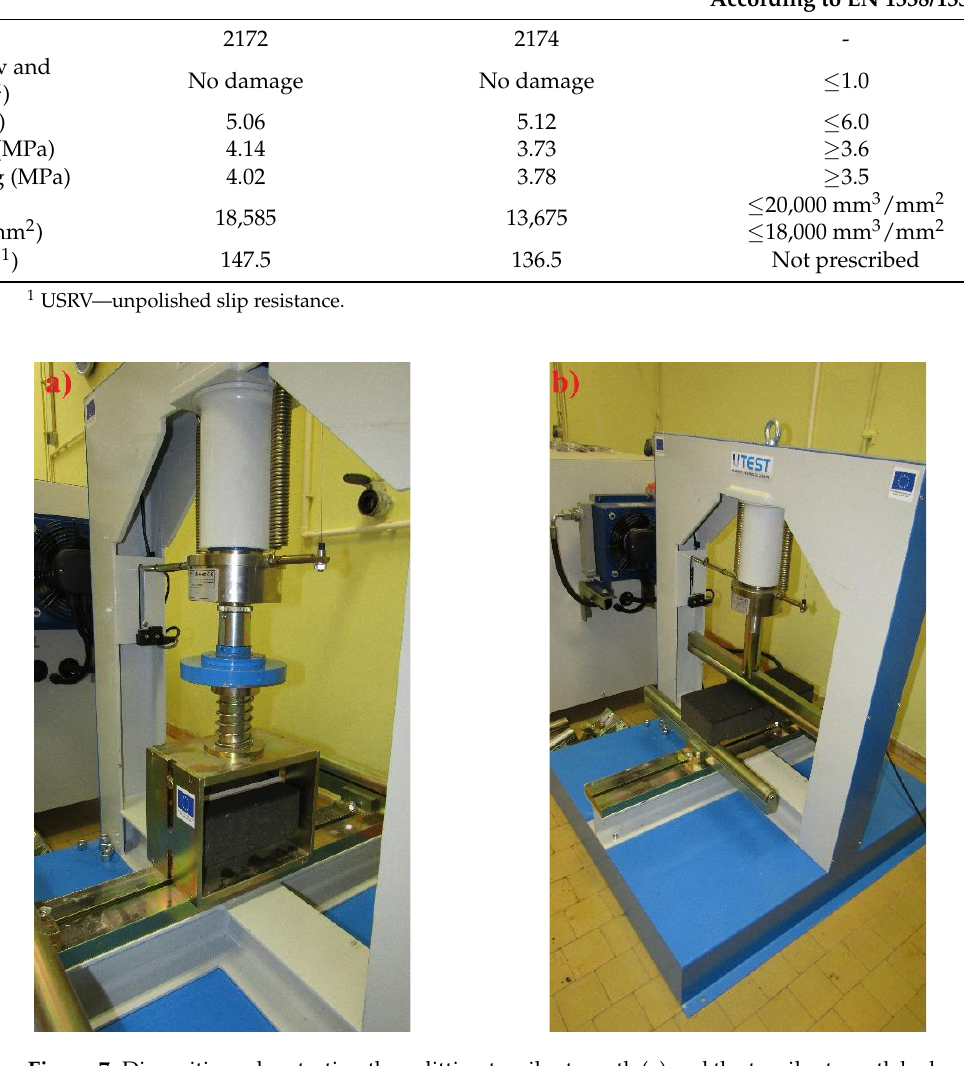
Figure 7. Disposition when testing the splitting tensile strength ( a ) and the tensile strength by bend- ing test ( b ). test ( b